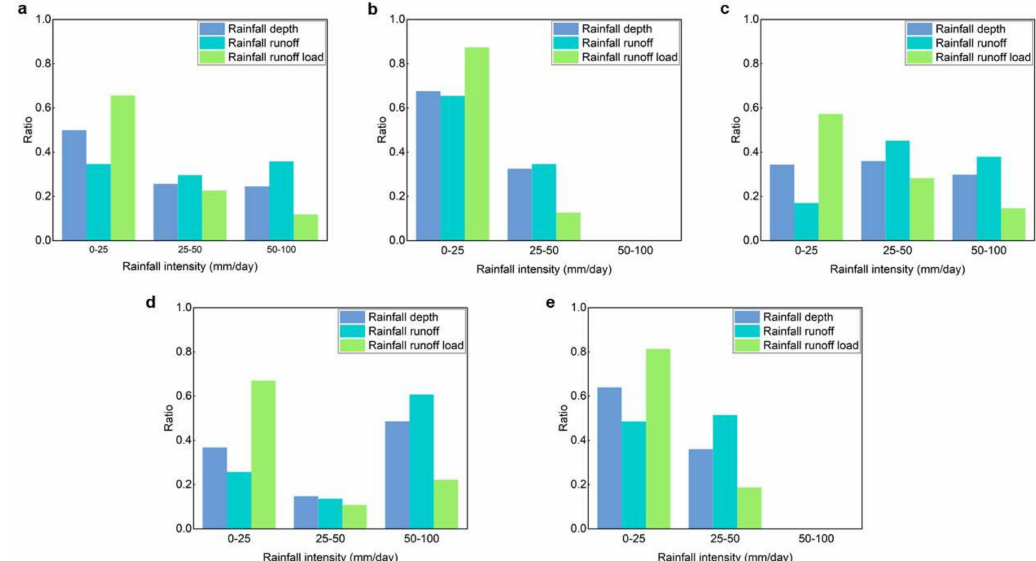
Figure 11. Ratio of rainfall runoff volume and nutrient load (example of COD) under three rainfall intensities during five summer months with peak rainfall depths greater than 200 mm: ( a ) June 2014 (246.5 mm/mon); ( b ) July 2014 (220.9 mm/mon); ( c ) August 2014 (238.5 mm/mon); ( d ) June 2015 (248.3 mm/mon); ( e ) August 2015 (238.5 mm/mon). There are high-intensity pollution patterns of rainfall runoff in July 2014 and August 2015.